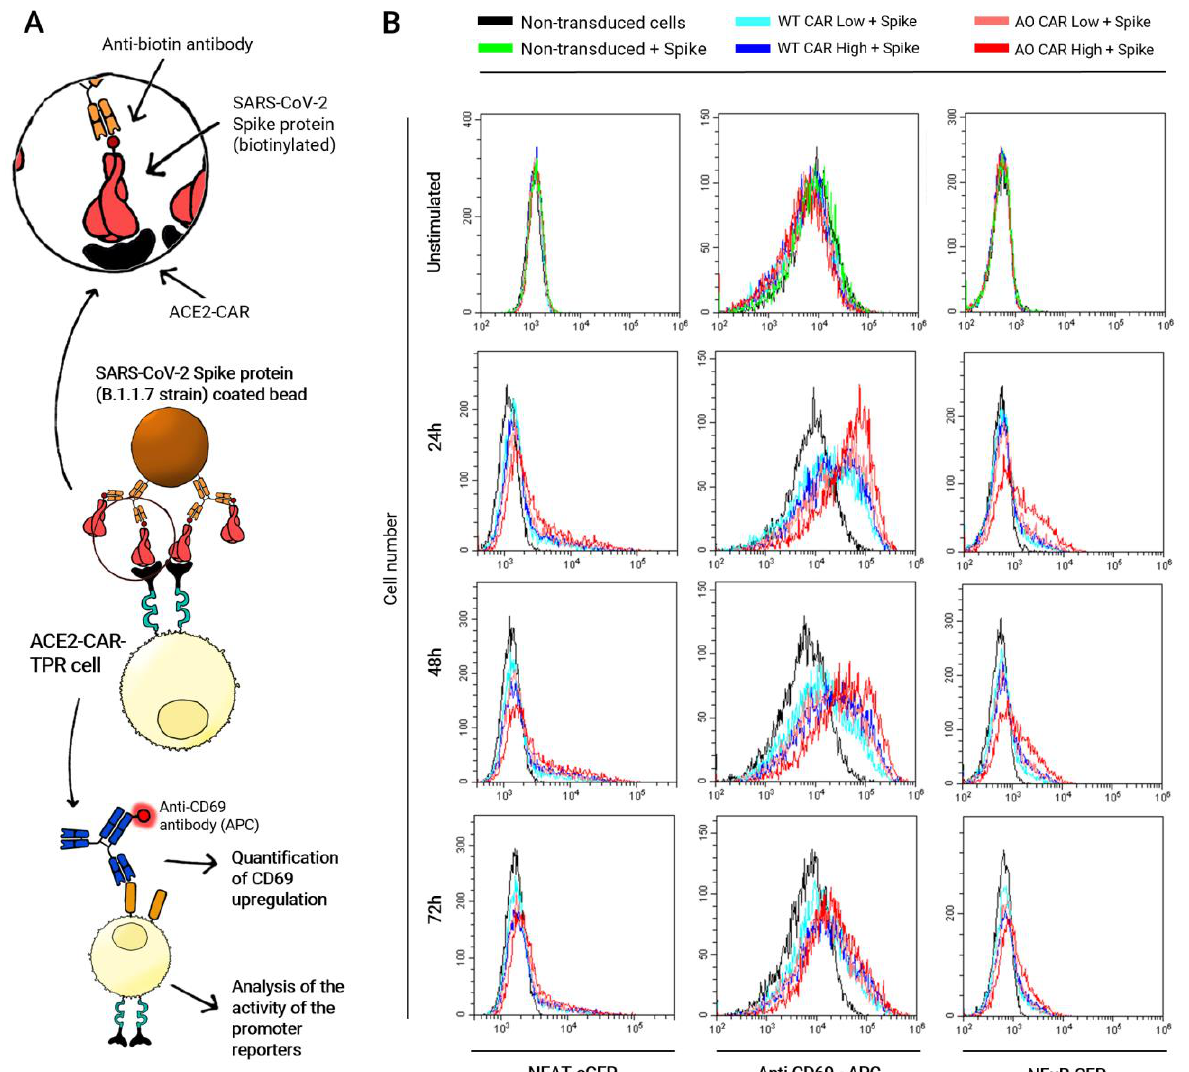
Figure 3. Activation of ACE2-CAR-TPR cells upon stimulation with Spike-coated MACSiBead particles. ( A ) Schematic illustration of the stimulation of ACE2-CAR-TPR cells with Spike and ( B ) Histogram overlays showing eGFP (NFAT), CFP (NF κ B) or CD69 upregulation 24, 48 and 72 h after stimulation with Spike trimers. A representative experiment out of three performed in triplicate is shown.